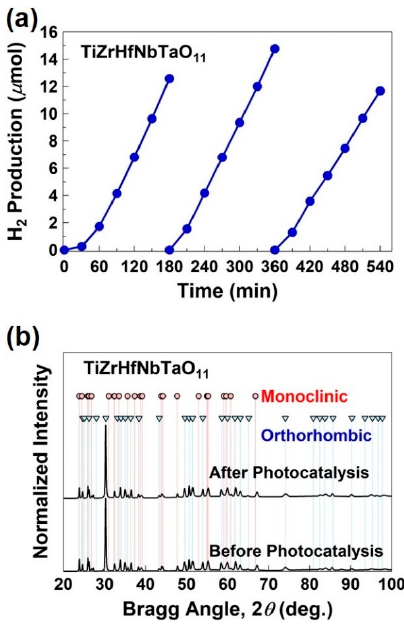
Figure 6. ( a ) Photocatalytic hydrogen production for three cycles and ( b ) X-ray diffraction patterns before and after photocatalysis for dual-phase high-entropy oxide TiZrHfNbTaO 11 , synthesized by high-pressure torsion and high-temperature oxidation, reproduced from [76], with permission from ROYAL SOCIETY OF CHEMISTRY,